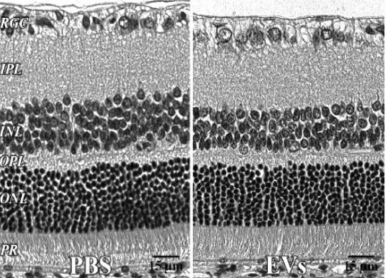
Figure 5. Retinal histology after intravitreal EVs. PBS—injected eye left; EV—injected right, both 7 days after injection, with no significant change in retinal cell layer thicknesses. 40x. RGC = retinal ganglion cell layer; INL = inner nuclear layer; IPL = inner plexiform layer; OPL = outer plexiform layer; ONL = outer nuclear layer; PR = photoreceptor layer. Scale bars (with black lettering, 15 µ m) are on bottom right of each